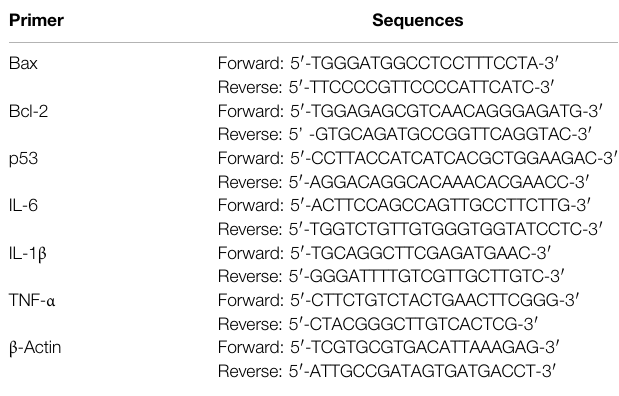
TABLE 2| Nucleotide sequences ofthegene-speci fi cprimersused